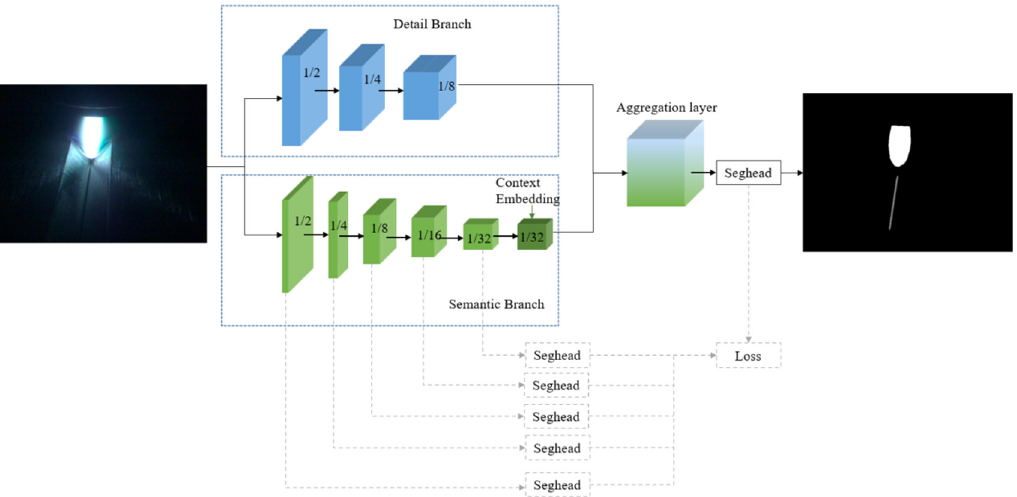
Figure 4. Network structure of